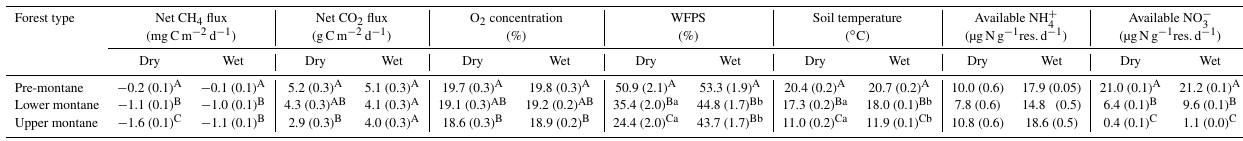
Table 2. Forest type means and standard errors for aggregated dry (May–September) and wet (October–April) season months. Capital letters indicate significant differences ( p <0.05) among forest types within season and lower case letters indicate significant differences between season within forest types.